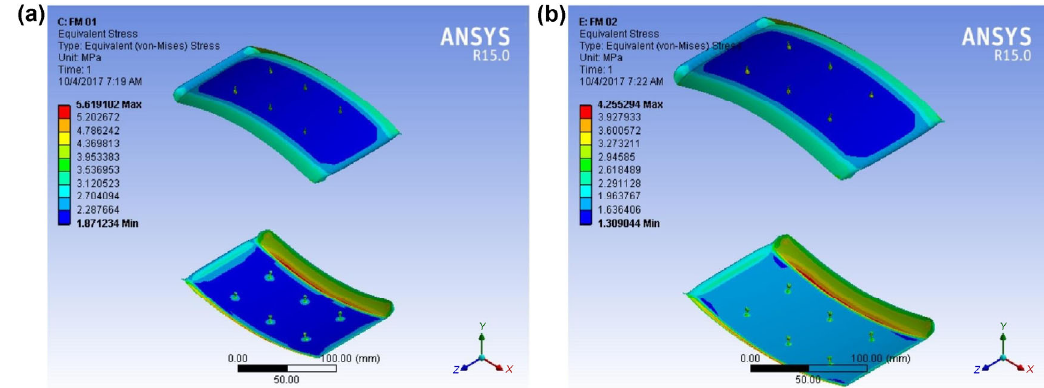
Fig. 7 Thermal stress distribution of the developed composite during maximum temperature rise for (a) FM01 and (b)